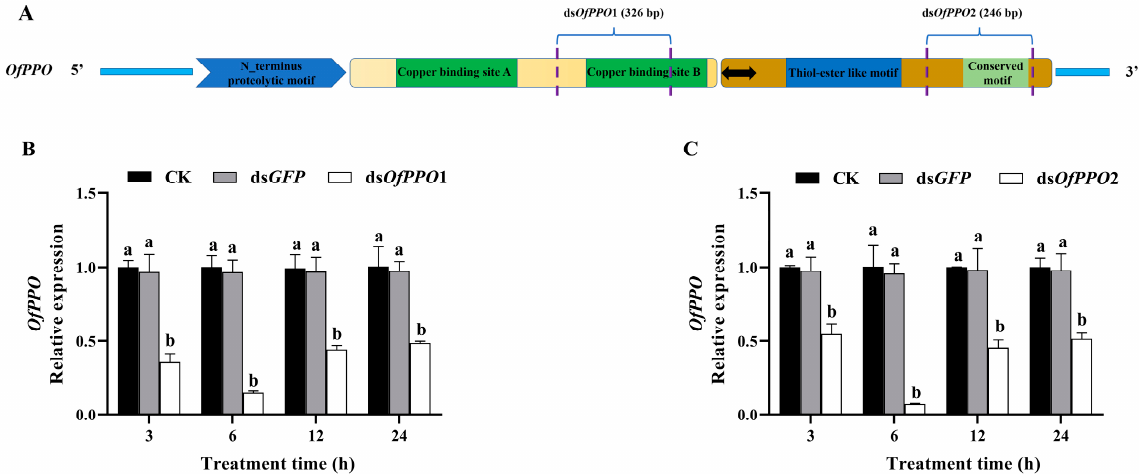
Figure 6. Analysis of the silencing efficiency of OfPPO in O. formosanus . ( A ) Conceptual diagrams illustrating the interference regions for designing dsRNA fragments (including ds OfPPO 1 and ds OfPPO 2). Black arrows indicate the regions for detecting the expression level of OfPPO by qPCR. ( B ) Relative expression levels of OfPPO in O. formosanus fed on ds OfPPO 1. ( C ) Relative expression levels of OfPPO in O. formosanus fed on ds OfPPO 2. The data are presented as the mean ± SD of three replicates. The same letters indicate no significant difference in the OfPPO expression ( p >